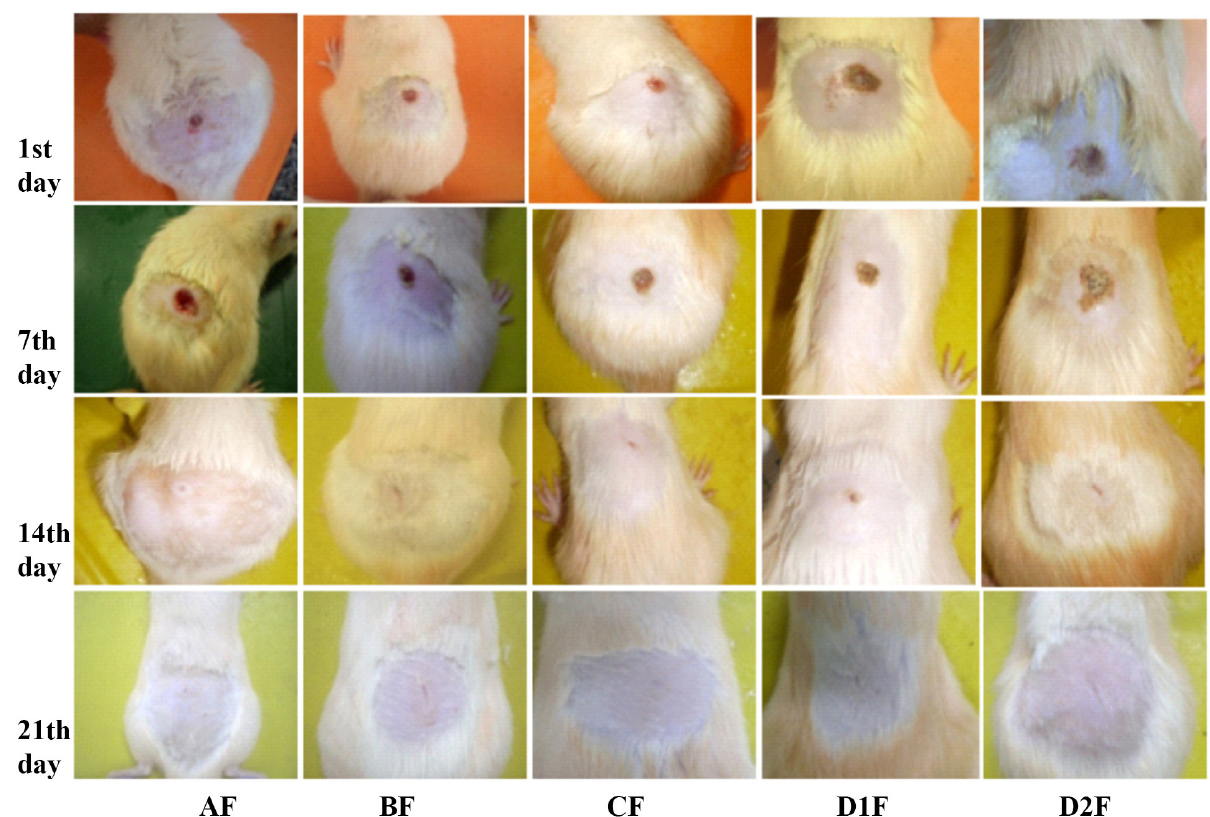
FIGURE 1 - Macroscopic analysis of cutaneous lesions of animals after 1, 7, 14 and 21 days of daily treatment. Key: Treatment groups: AF – physiological serum, BF - collagenase, CF – natural palygorskite, D1F – organophilic palygorskite with cetyl trimethyl ammonium chloride, D2F – organophylic palygorskite with alkyl dimethyl benzyl ammonium chloride, F – wound.